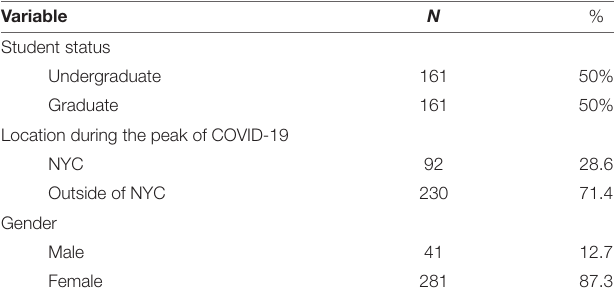
TABLE 1 | Demographic characteristics of participants ( N =